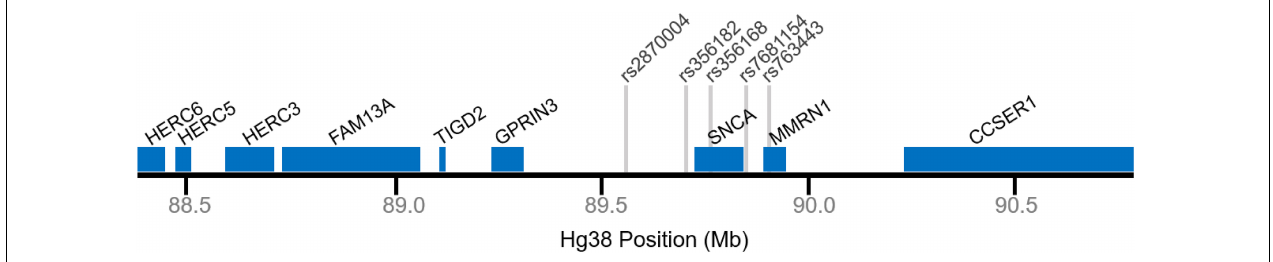
FIGURE 1 | Genomic map of the SNCA locus. Selected gene positions displayed in blue. Gray lines denote relative single nucleotide polymorphism (SNP)